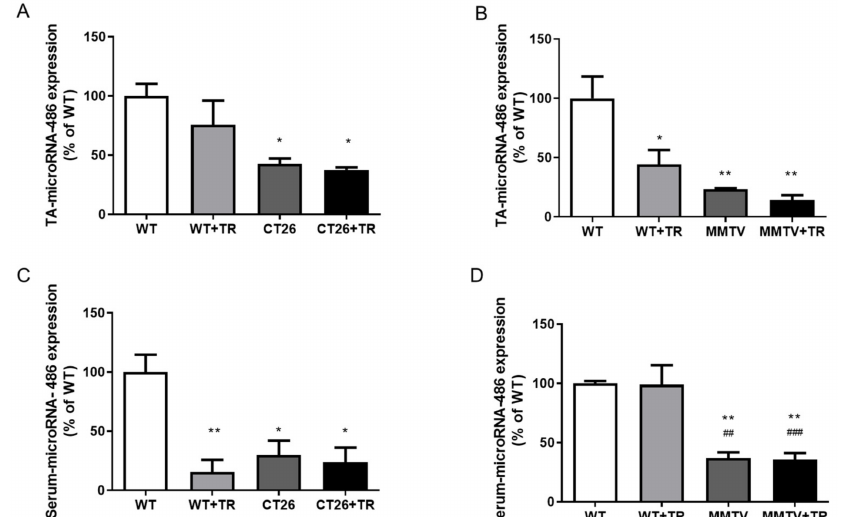
Figure 5. MicroRNA-486 expression in tibialis anterior (TA) skeletal muscle and circulating in CT26- cachectic and MMTV-PyMT-non-cachectic mice. ( A ) CT26 model, skeletal muscle microRNA-486 expression. ( B ) MMTV model, skeletal muscle microRNA-486 expression. ( C ) CT26 model, serum microRNA-486 expression. ( D ) MMTV model, serum microRNA-486 expression. Groups CT26 cachectic mice: WT—wild type sedentary; WT+TR—wild type trained; CT26—colon cancer sedentary; CT26+TR—colon cancer trained. Groups MMTV non-cachectic mice: WT—wild type sedentary; WT+TR—wild type trained; MMTV—mammary cancer sedentary; MMTV+TR—mammary cancer trained. Data are reported as means ± SEM, * p < 0.05 vs. WT, ** p < 0.01 vs. WT, ## p < 0.01 vs. WT+TR and ### p < 0.001 vs.